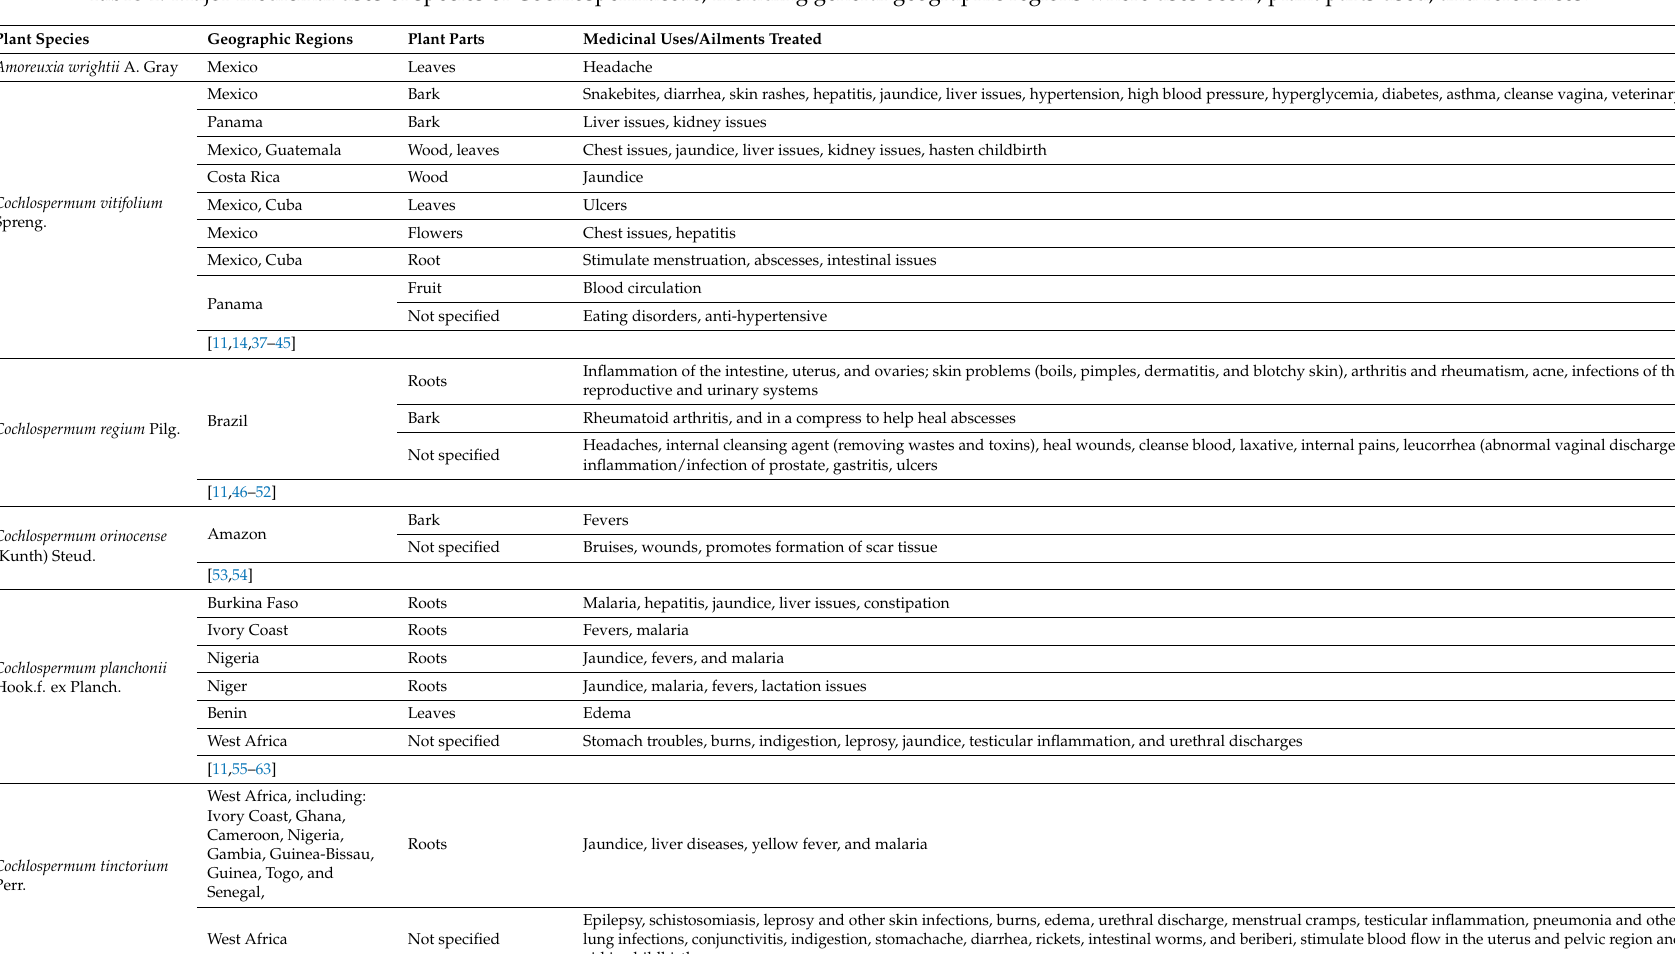
Table 1. Major medicinal uses of species of Cochlospermaceae, including general geographic regions where uses occur, plant parts used, and references. Plant